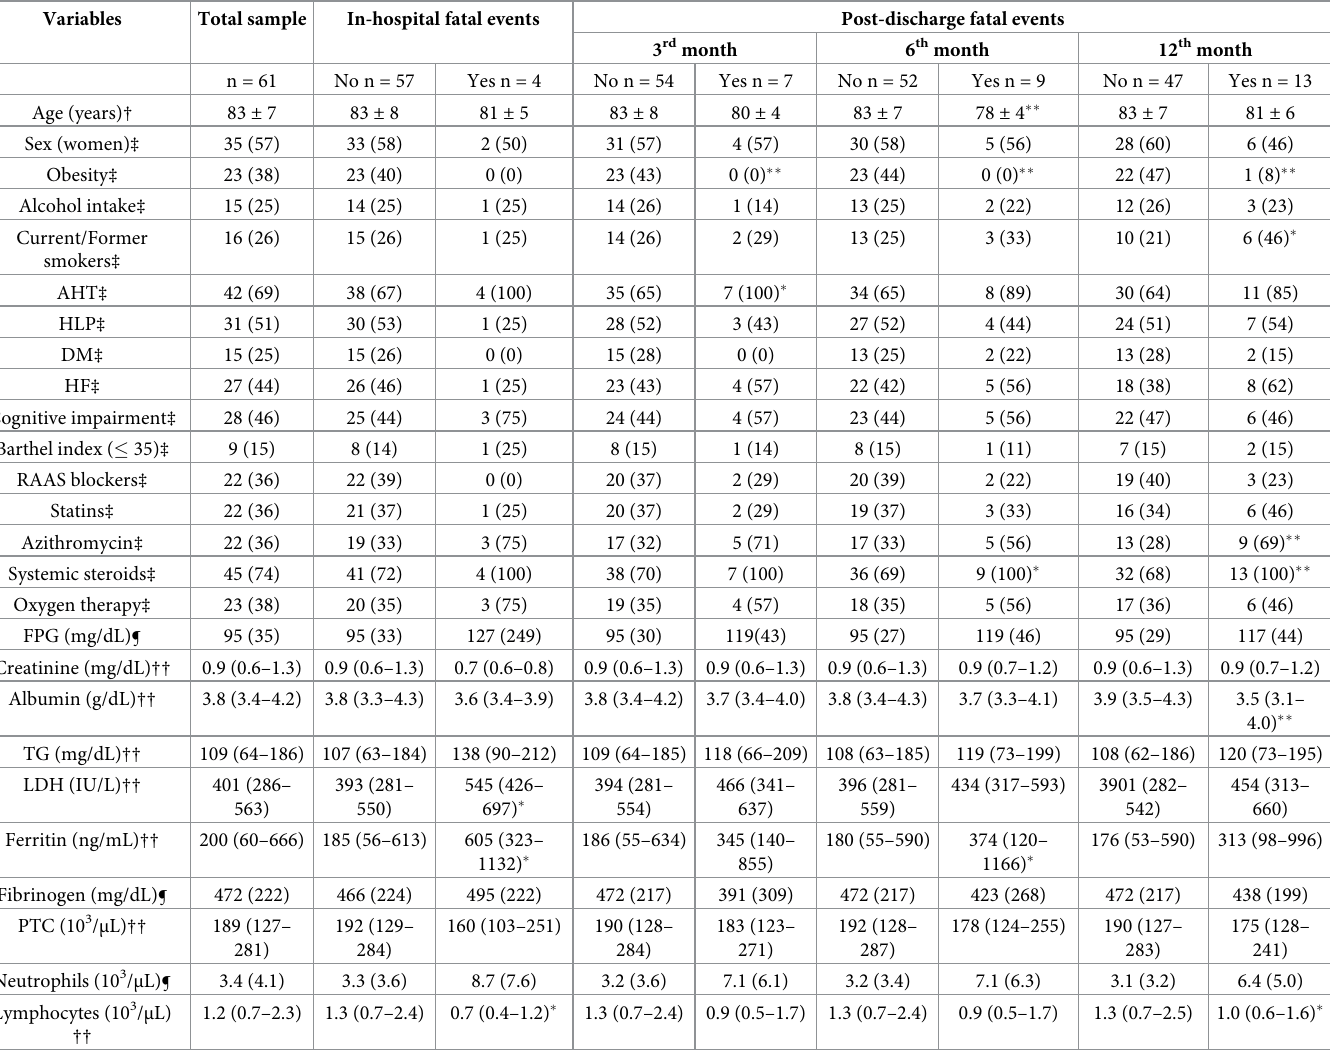
Table 1. Clinical and laboratory features of the comparison groups attending to